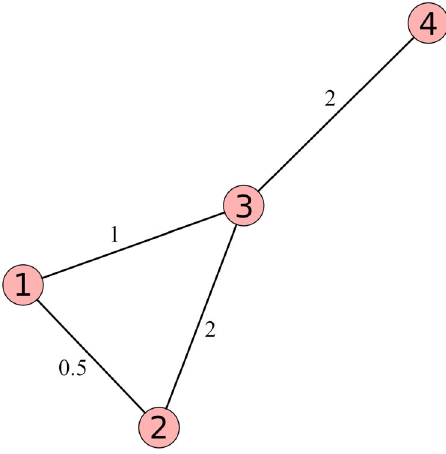
Fig. 6 | Example of a network composed of 4 nodes and 4 links, with different valuesoftopologicalweights. Theweightsre fl ectthestrengthoftheconnections between nodes.